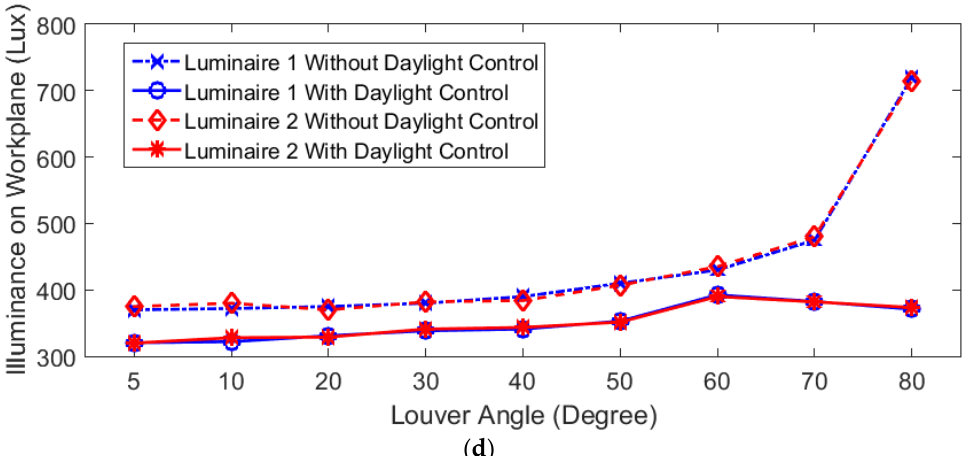
Figure 9. Effect of Louver angle on electrical and illuminance data obtained from experimental setup at 01.00 P.M.: ( a ) Voltage; ( b ) Current; ( c ) Power; ( d ) illuminance on working plane.